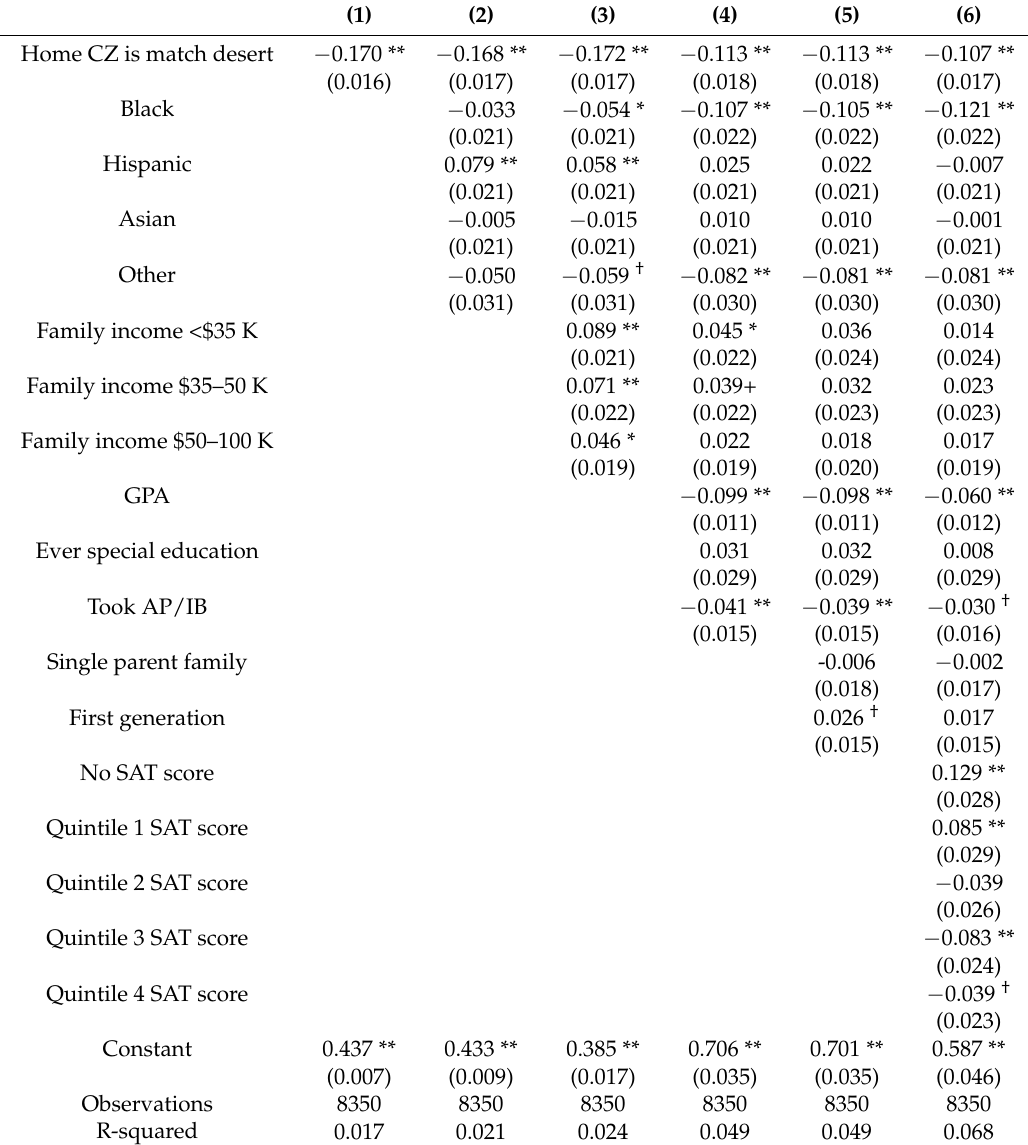
Table A5. Relationship between living in match desert and applying to a strict academic-match